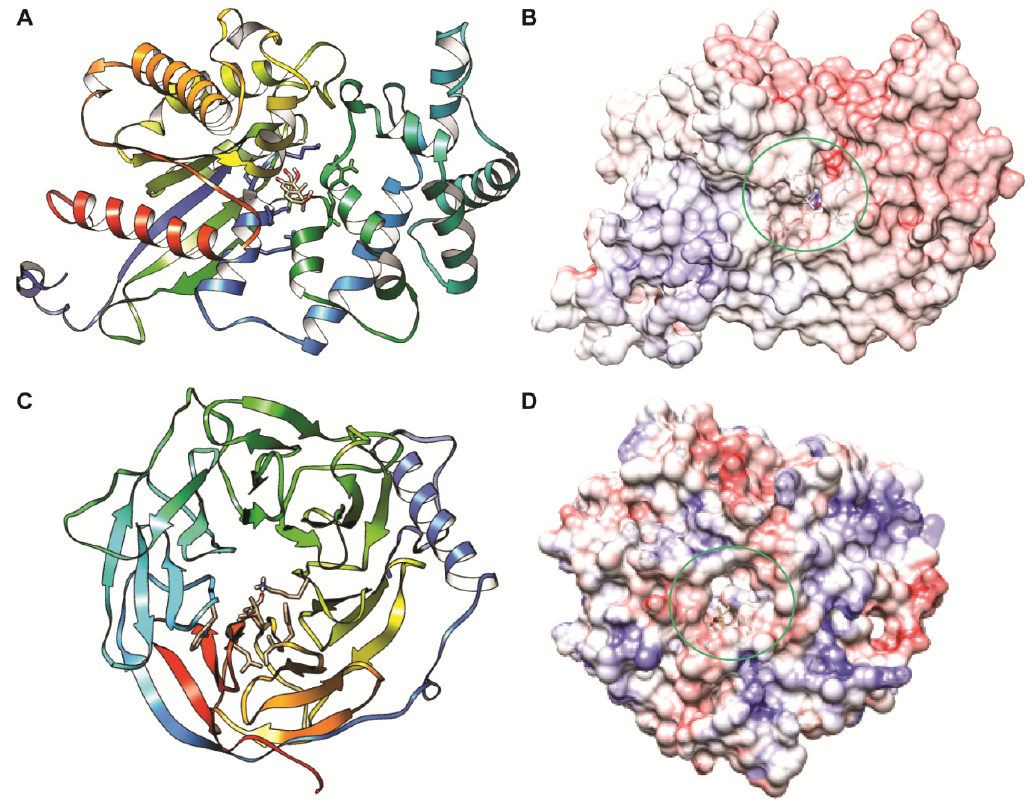
Figure 4. Docked conformational states and electrostatic surface representation of Bipolaroxin with G-protein alpha and G beta subunit. ( A ) Solid ribbon representation of the G-protein alpha subunit with Bipolaroxin (stick format) with the binding pocket residues. ( B ) Electrostatic surface potential map of G-protein alpha subunit with Bipolaroxin (ligand binding pocket has been marked in circle). ( C ) Solid ribbon representation of the G protein beta subunit with Bipolaroxin (stick format). ( D ) Electrostatic surface potential map of G protein beta subunit with Bipolaroxin (ligand binding pocket has been marked in circle). The electrostatic surface potential maps were generated using APBS and rendered using Chimera.